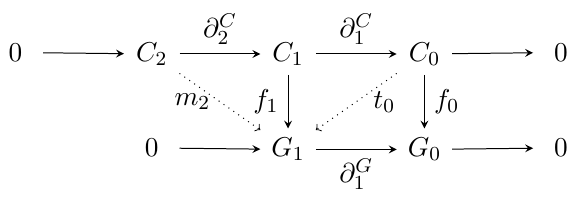
Figure 8 . Chain complexes for the 0 ; 1-gauge model in 5.2. The con(cid:12)gurations for the links are determined by f 1 , while for the vertices by f 0 . The gauge transformations are given by t 0 , while we have the 1-holonomies m 2 and 0-holonomies m 1 not shown in the (cid:12)gure. because Ext 1 ( Z ; G ) = f 0 g [33], we 2